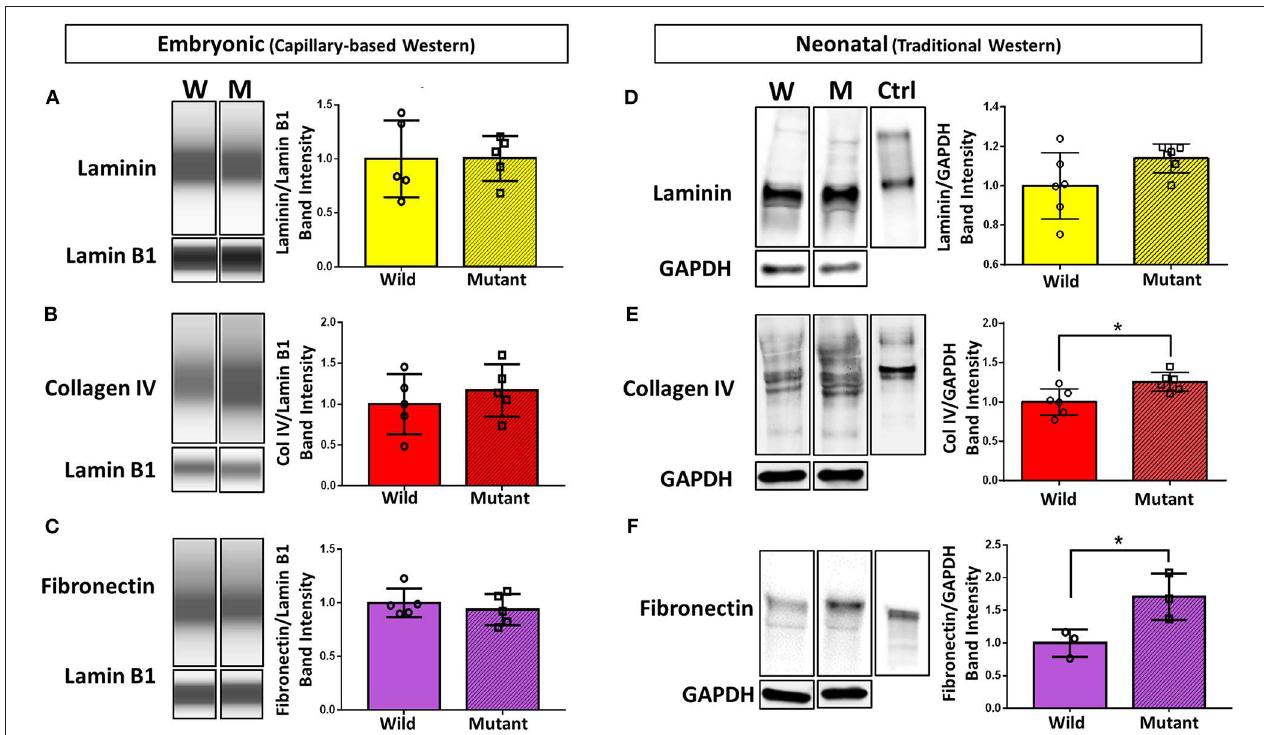
FIGURE 2 | Western blotting detects significant differences in collagen IV and fibronectin at the neonatal age, but no differences in ECM expression between embryonic Nkx2-5 mutant and wild type mouse hearts. For embryonic heart samples: ECM capillary-based Western band images for embryonic heart samples (left) and subsequent quantification (right) for laminin (A) , collagen IV (B) , and fibronectin (C) . Each lane displays a representative “pseudoblot” band for each group, with n = 5 for each group. Each target ECM protein band intensity was normalized to that sample’s lamin B1 intensity. For neonatal heart samples: traditional Western blotting representative bands (left) of (D) laminin ( n = 12 total), (E) collagen IV ( n = 12 total), and (F) fibronectin ( n = 6 total) and corresponding quantifications (right). Control (“Ctrl”) lane shows each respective purified protein probed with the same primary antibody as the samples. Each target ECM protein band intensity was normalized to that sample’s GAPDH intensity. Graphs display mean ± standard deviation of ECM band intensities normalized to housekeeping protein, relative to wild type group. Significance * p < 0.05. W, wild type; M,